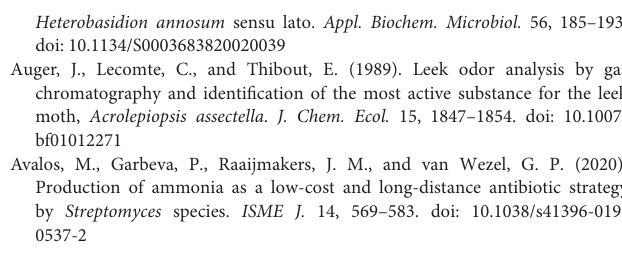
Supplementary Figure 7 | Experiment G. Volatilome analysis of Pseudomonas protegens CHA0 grown on Luria-Bertani agar (LBA) or potato dextrose agar (PDA)